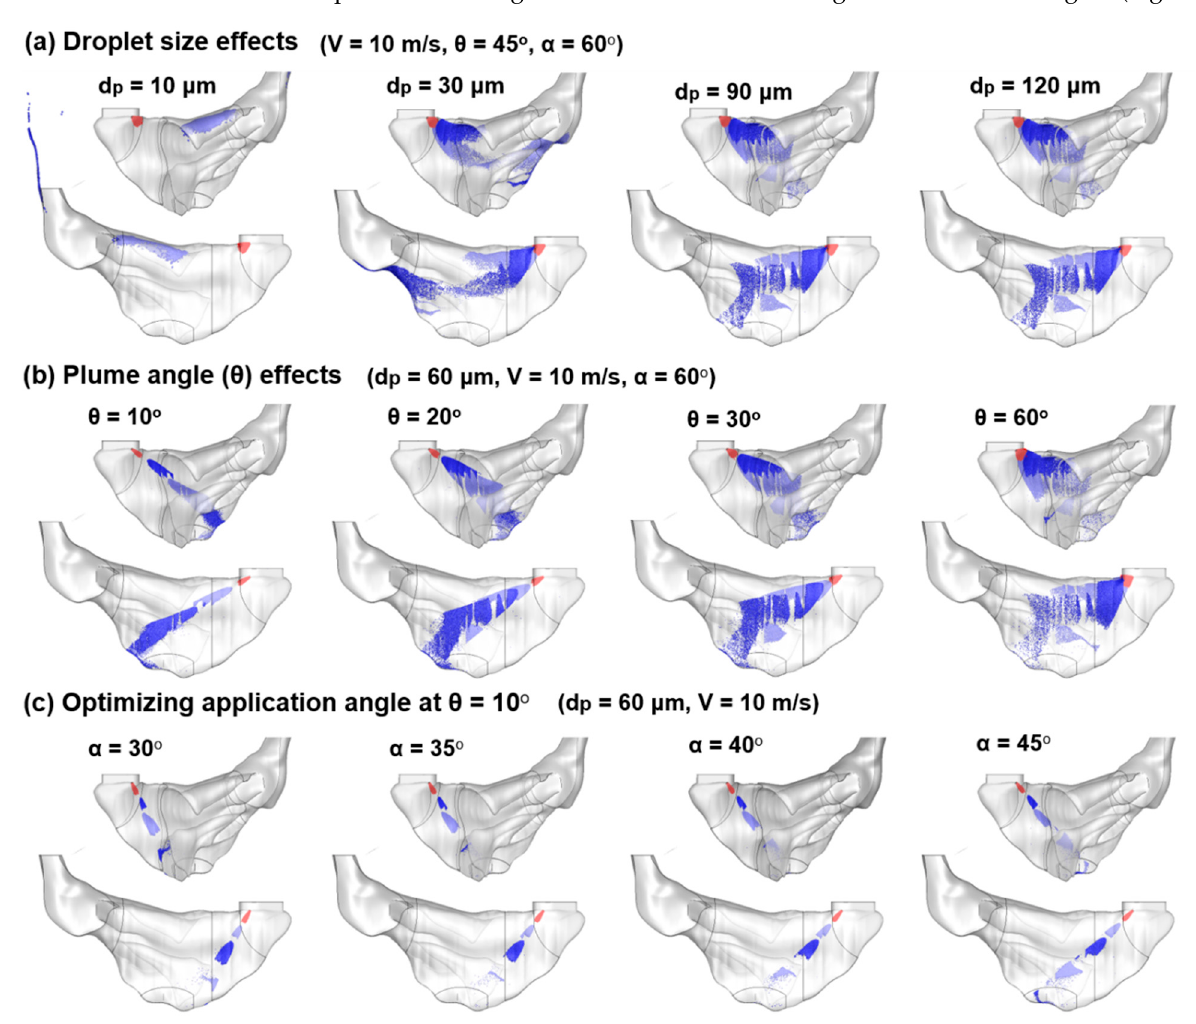
Figure 7. Deposition distribution of spray droplets with different properties: ( a ) droplet size, d p : 10–120 µ m; ( b ) spray plume angle, θ : 10°–60°; ( c ) application angle, α in the range of 30°–45° at the selected plume angle, θ = 10°.